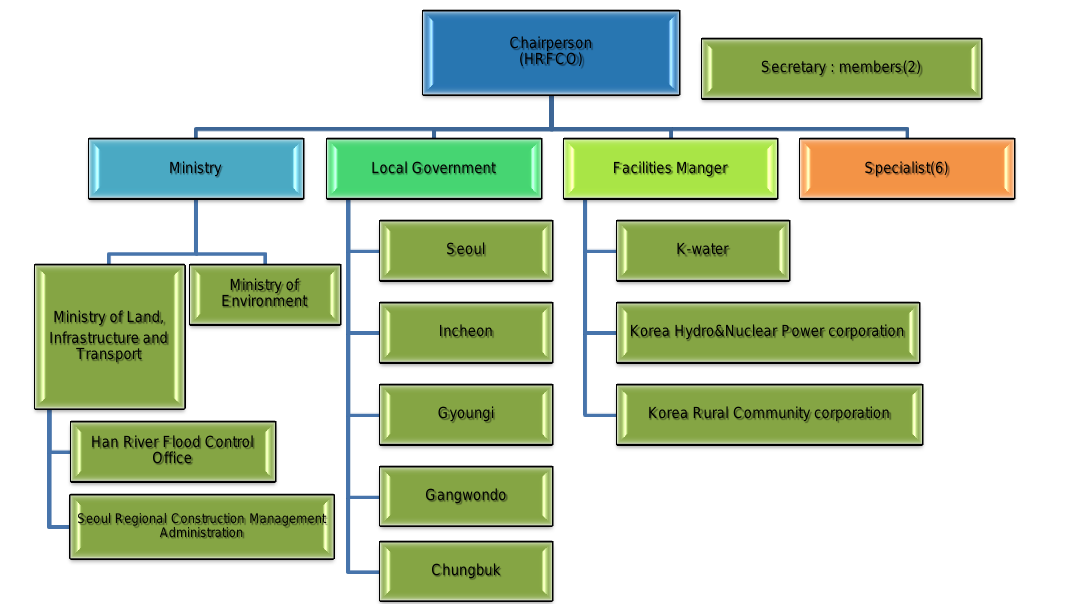
Figure 2. Regulation Council for the conjunctive operation of dams/weirs Council(18): MOLIT(3), MOE(1), Local Government(5), Dam operation(3), Specialist(6).